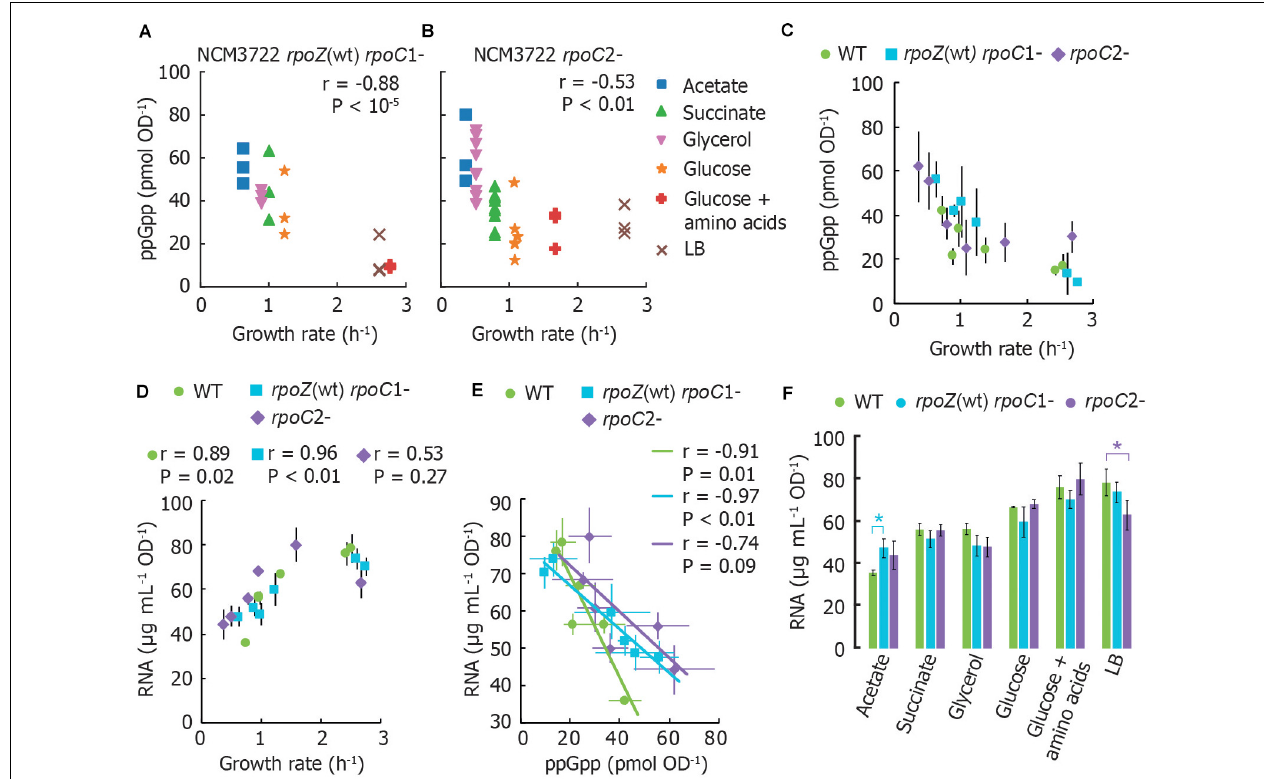
FIGURE 2 | RNA polymerase mutants without ppGpp binding site 1 or 2 still exhibit the typical ppGpp and RNA vs. growth rate trends. (A) Basal ppGpp in NCM3722 rpoZ (WT) rpoC 1- and in (B) NCM3722 rpoC 2- (showing technical replicates, 3 per culture). (C) Averaged data of A and B overlapped with average NCM3722 wild type data from Figure 1A . (D–F) The total RNA concentration of NCM3722 wild type and rpoC mutants in various growth media. Error bars represent standard deviations. (D) Total RNA concentration plotted as a function of growth rate. (E) Data of D plotted as a function of ppGpp concentrations with a linear fit. The average or each condition is shown. See Supplementary Section 3 for materials and methods. (F) Data of D plotted to compare RNA content between strains grown in identical media. Bars represent the average of three technical replicates of one culture, with exception of rpoC 2- in glycerol (2 cultures, 6 replicates) and succinate (3 cultures, 9 replicates). * P < 0.05 for a two-tailed student’s t -test. For (A,B,D,E) , the Pearson correlation coefficient r and significance figure P (from a two-tailed significance test) is